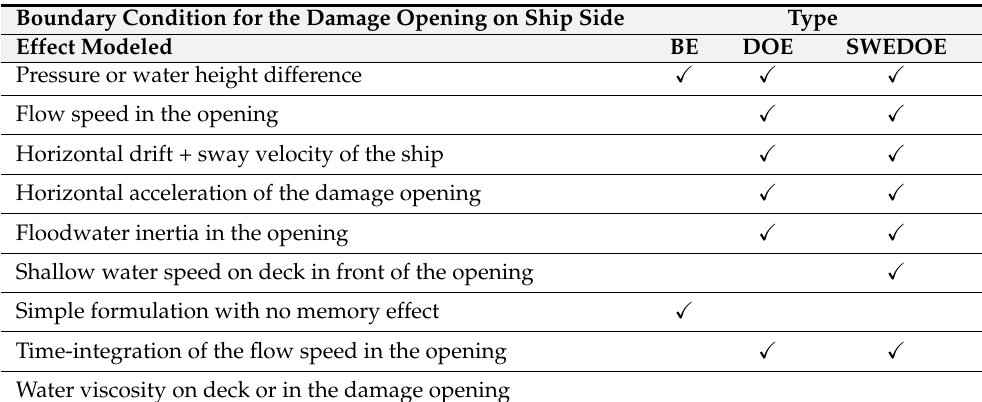
Time-integration of the flow speed in the opening Water viscosity on deck or in the damage